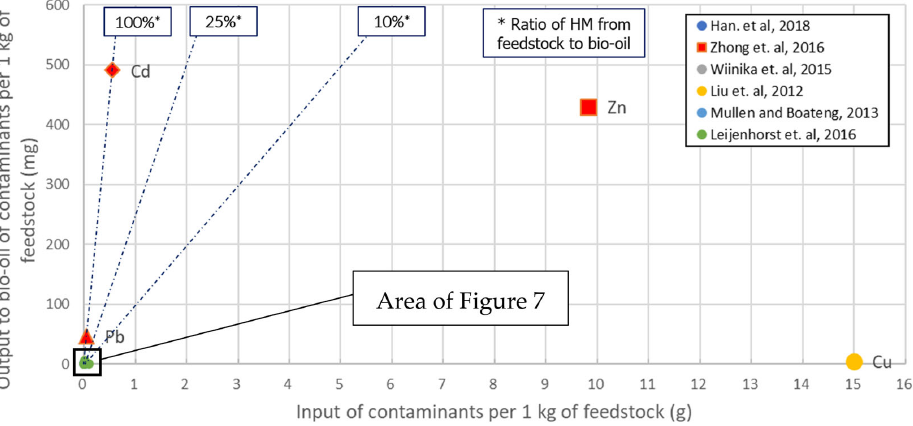
Figure 6. Pyrolysis: Output to bio ‐ oil vs. input with feedstock of HM species. All available input loads are shown. Adapted from [62,64,86,97,110,117].